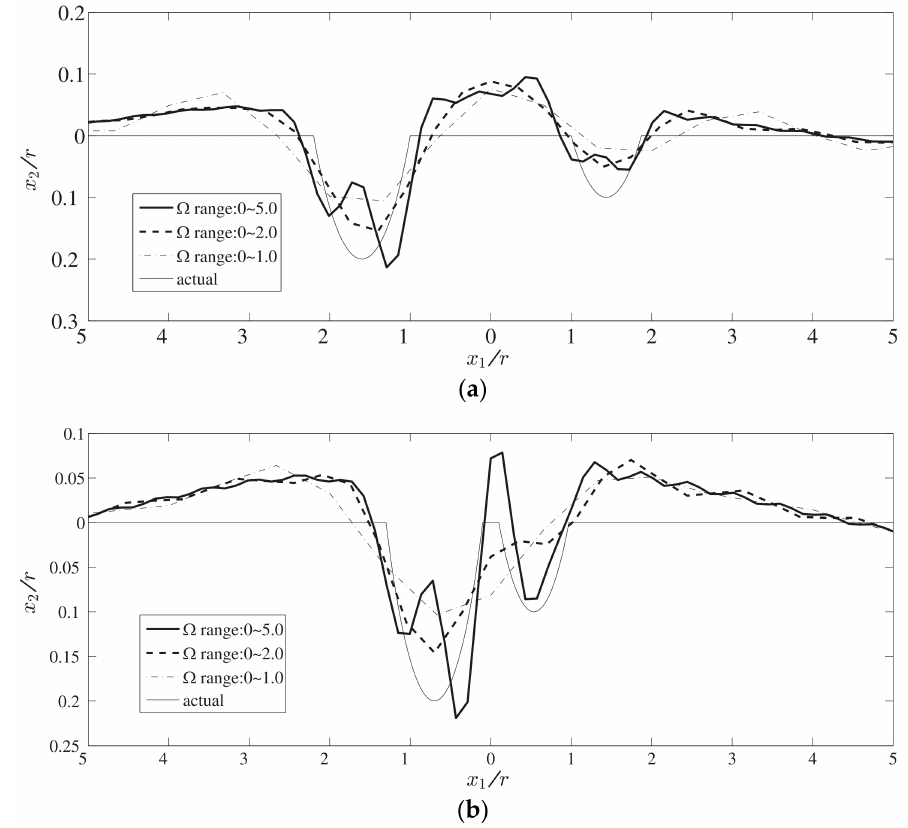
Figure 10. Inverse reconstruction results of surface canyon-shaped flaws with different frequency ranges ( a ) d max / r = 0.2; ( b ) d max / r =